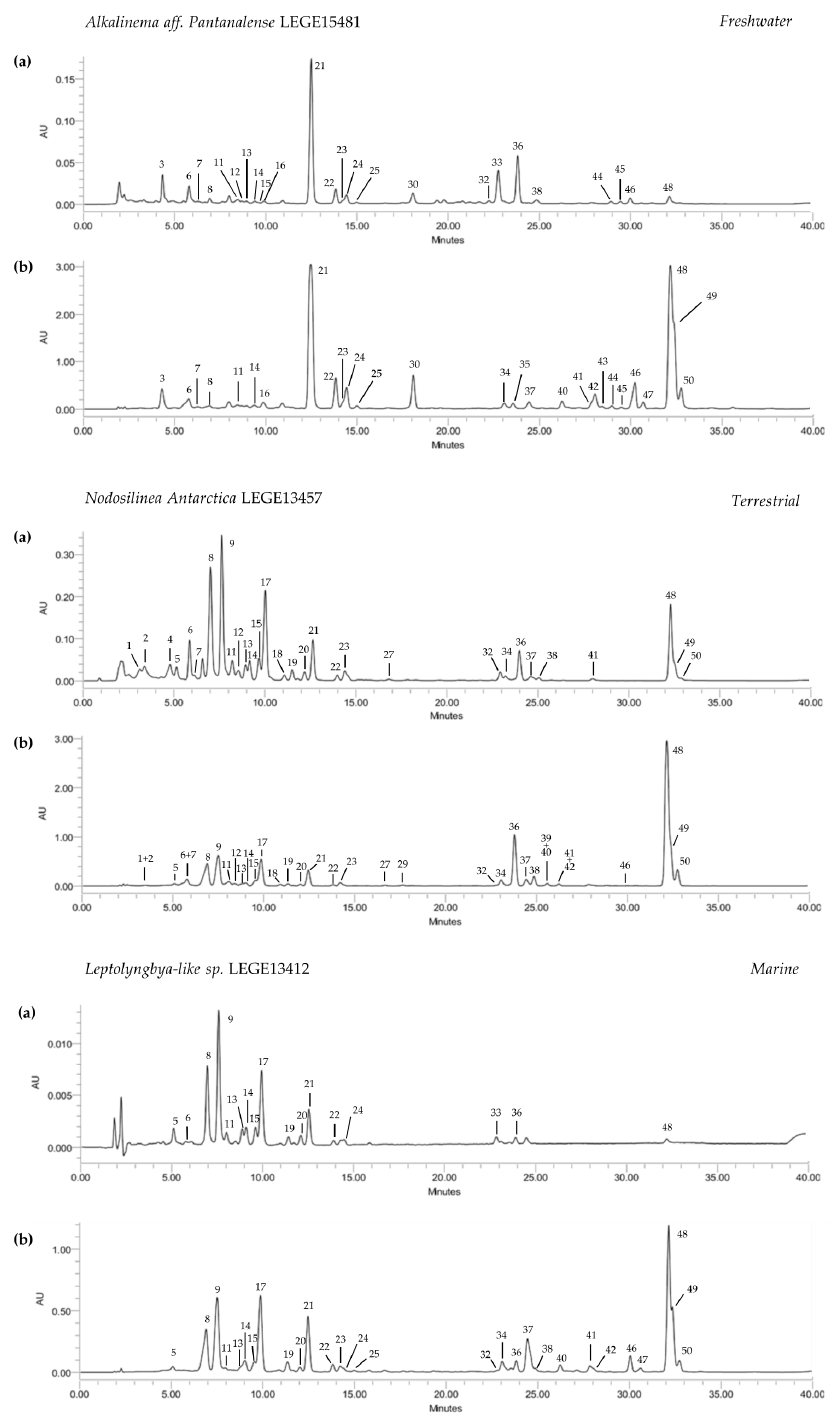
Figure 1. Carotenoid and chlorophyll profiles of ethanol ( a ) and acetone ( b ) extracts of cyanobacteria strains from different environments. HPLC-PDA recorded at 450 nm. Unidentified carotenoids (3, 5–8, 10–13, 15, 23, 25, 28, 31, 40–43), β -carotene oxygenated derivatives (9, 17, 34, 35), Lutein derivatives (14, 16, 19, 22, 24), Echinenone derivatives (30), Chlorophyll a derivatives (32, 33, 38), Unidentified Chlorophylls (44–47), Zeaxanthin (21), Canthaxanthin (26), Chlorophyll a (36), Echinenone (37), all-trans β -Carotene (48), α -Carotene derivative (49), 13-cis- β -Carotene (50).